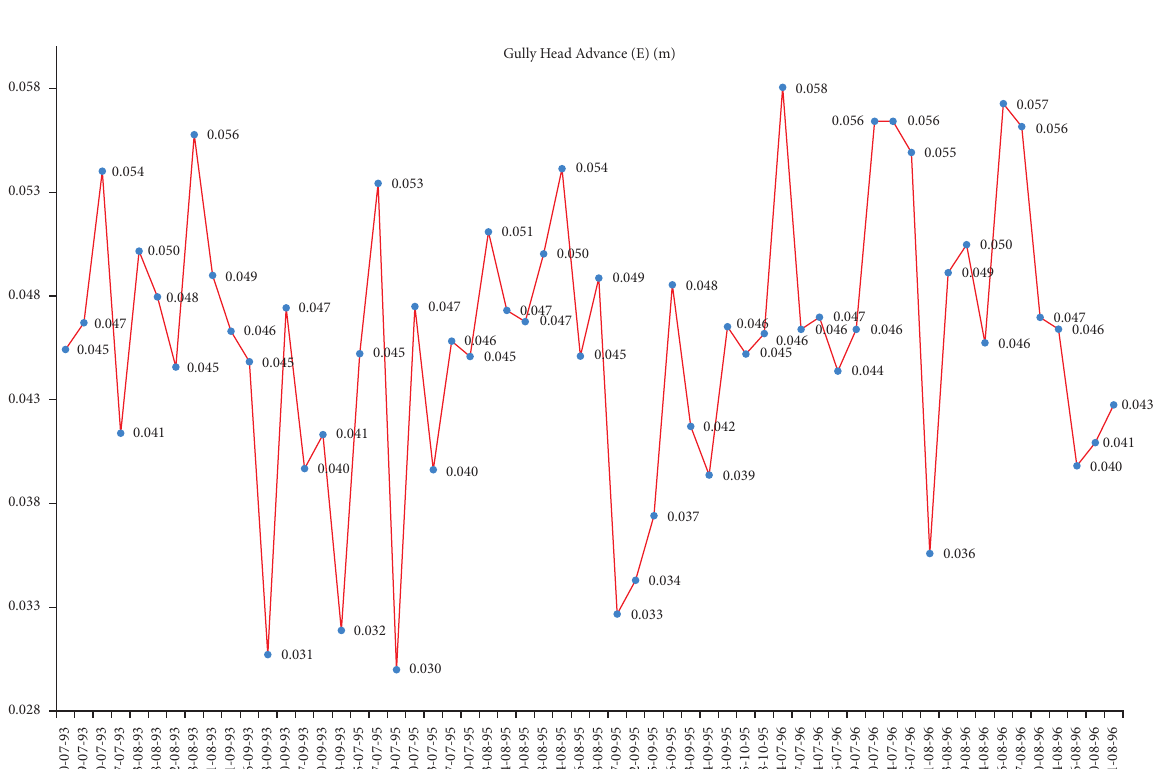
Figure 6: Estimated gully head advance with the selected dates of rainfall